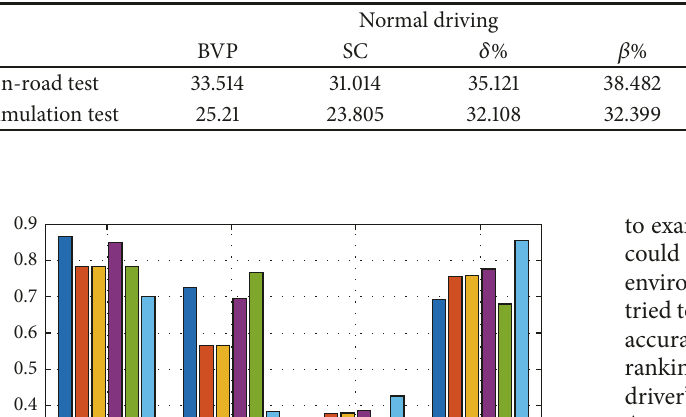
Table 6: The comparison between on-road test and driving simulation test.